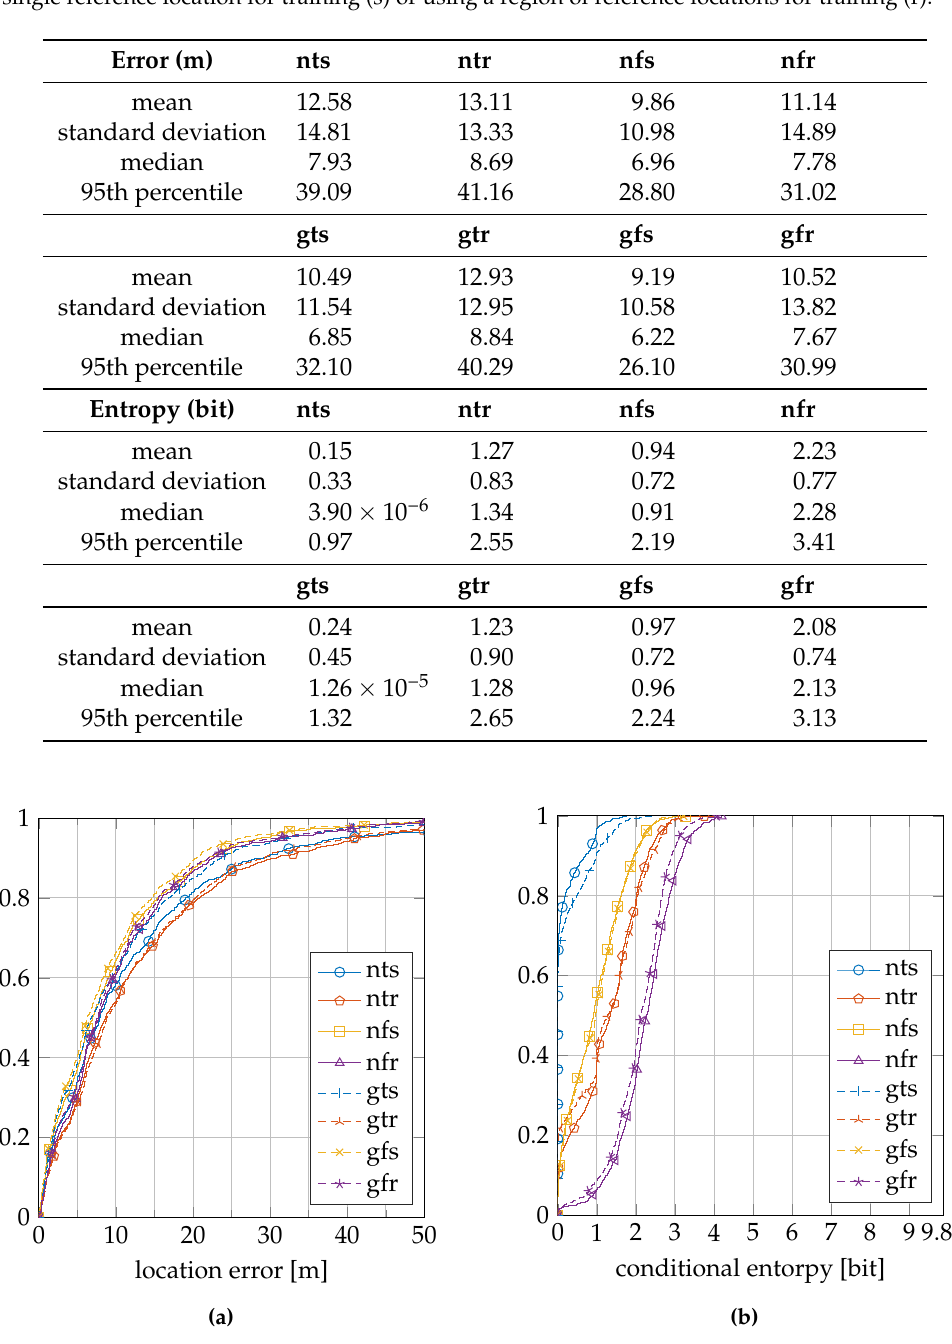
Figure 9. UJIIndoorLoc cumulative distributions: ( a ) location error; ( b ) conditional entropy. The legend labels refer to using the normal sensor model (n) or using the convolution sensor model (g), using the trained σ (t) or using the fixed σ (f) and using a single reference location for training (s) or using a region of reference locations for training